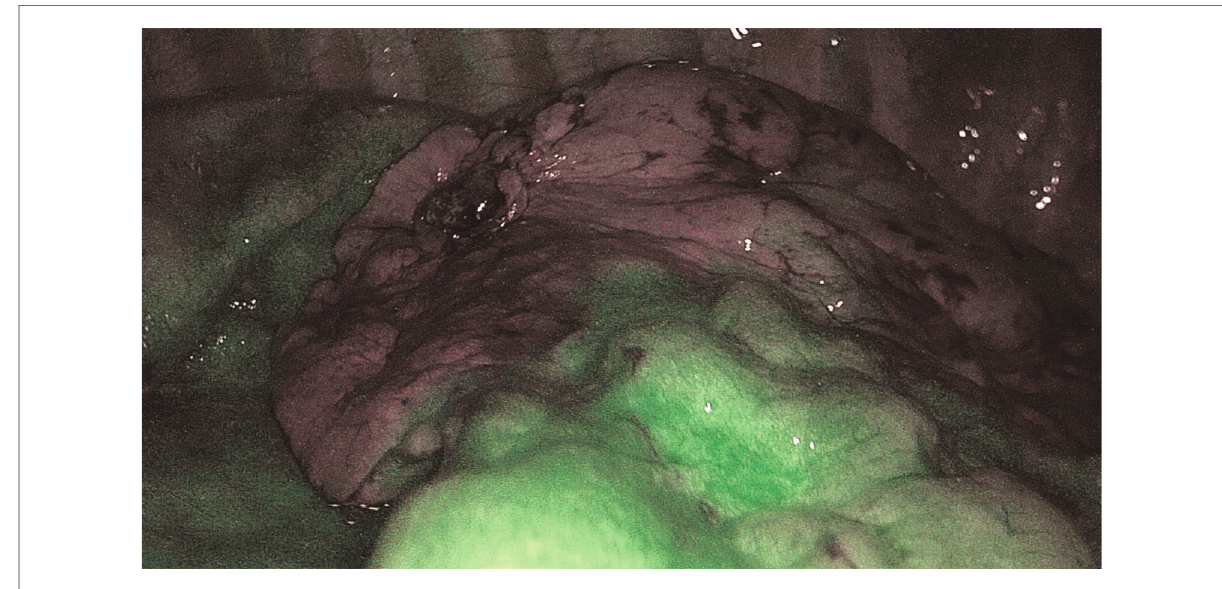
FIGURE 1 Intersegmental plane identi fi cation using ICG during VATS